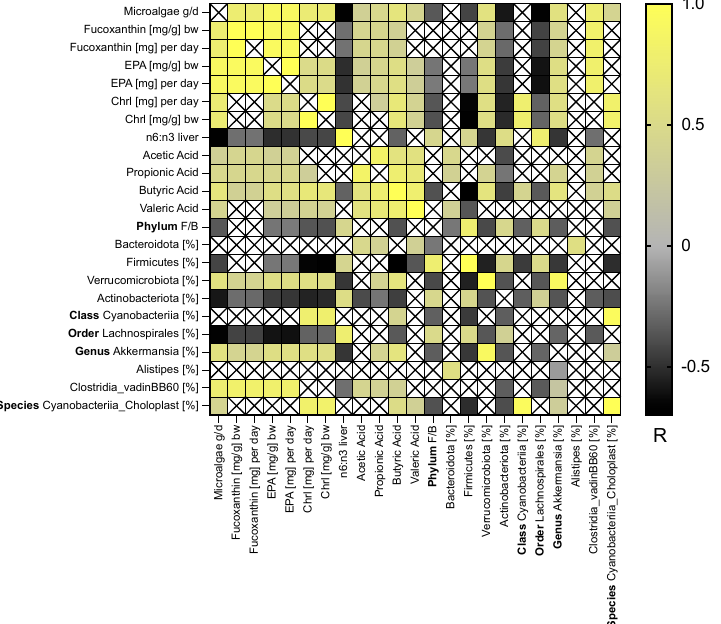
Figure 5. Heat map of Spearman’s rank correlation measured by Spearman rho (R) comparing the microalgae intake/day, EPA, Fx, and Chrl intake mg/day and mg/g bw with the n:6-n:3 ratio in the liver, SCFA amounts (acetic, propionic, butyric, and valeric acid), and gut microbiome as the relative bacterial abundances [%] at the phylum, class, order, genus, and species levels. Abbreviations: X, no significance at p -values > 0.05; bw, body weight; EPA, eicosapentaenoic acid; Chrl, chrysolaminarin intake; F/B, Firmicutes/Bacteroidota ratio; for further abbreviations, see Table 1 and Figure 1. The connection between the SCFA amounts and some bacteria was elucidated. A level and Clostridia vadinBB60 at the genus level. The Bacteriodota Verrucomicrobiae at the related with propionic acid. The propionic acid amount and the Actinobacteria abundance are negatively correlated at the phylum level. For butyric acid, a positive correlation was detected between the Verrucomicrobiae at the phylum level; Cyanobacteriia at the class level; and Akkermansia , Clostridia vadinBB60 , and Cyanobacteriia_Choroplast at the genus level. A negative correlation was shown between the abundance of Firmicutes and Actinobacterota at the phylum level and Lachnospirales at the order level. For valeric acid, Bacteroidota and Cyanobacteriia_Choroplast were positively correlated at the phylum level, whereas Firmicutes correlated negatively at the phylum